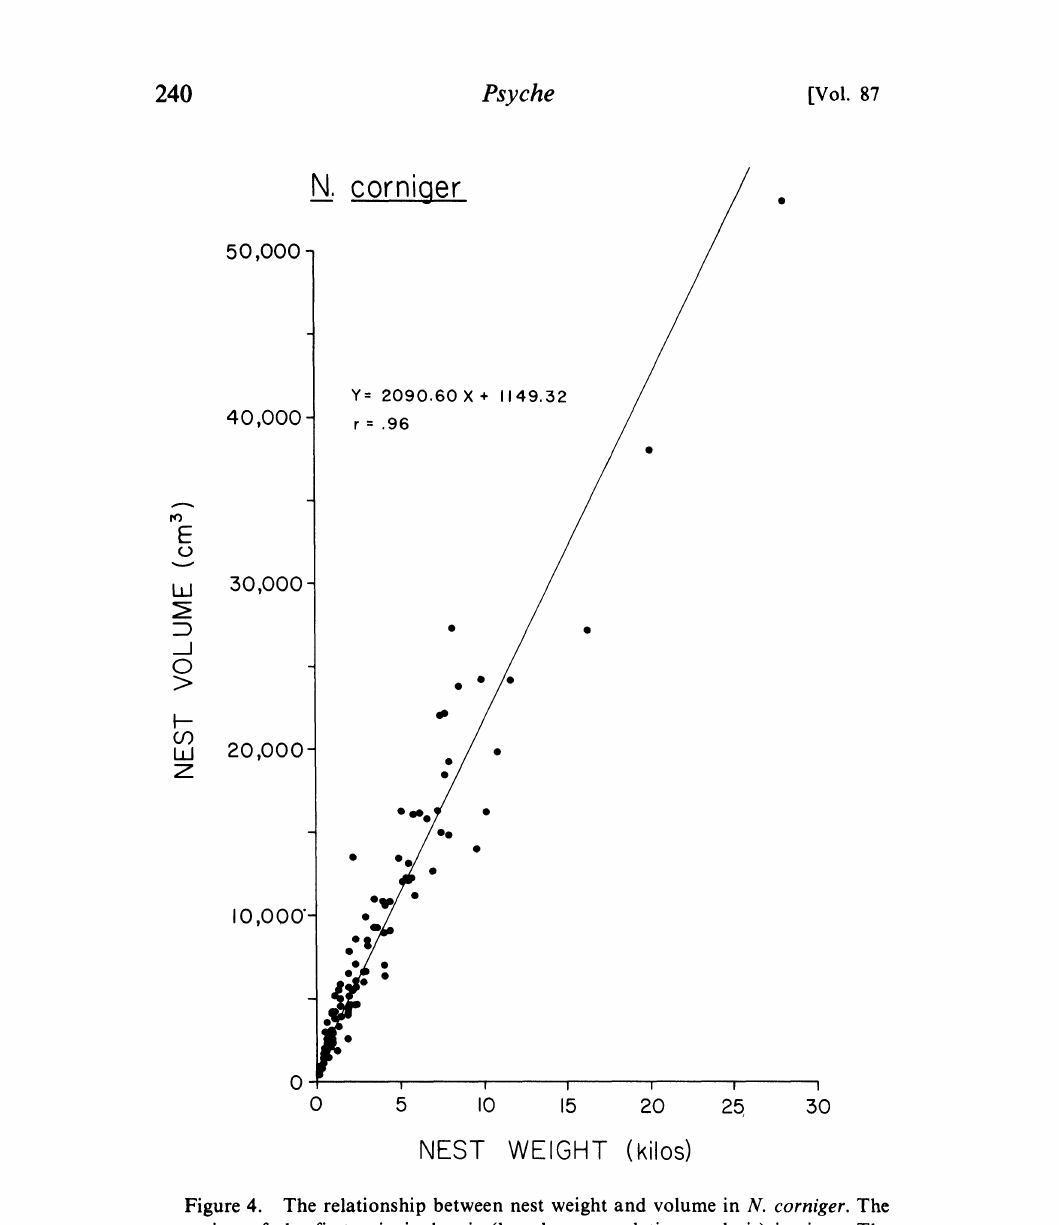
Figure 4. The relationship between nest weight and volume in N. corniger. The equation of the first principal axis (based on correlation analysis) is given. The correlation coefficient (r) is highly significant (p < 0.001). The 95% confidence limits on the slope of the principal axis are